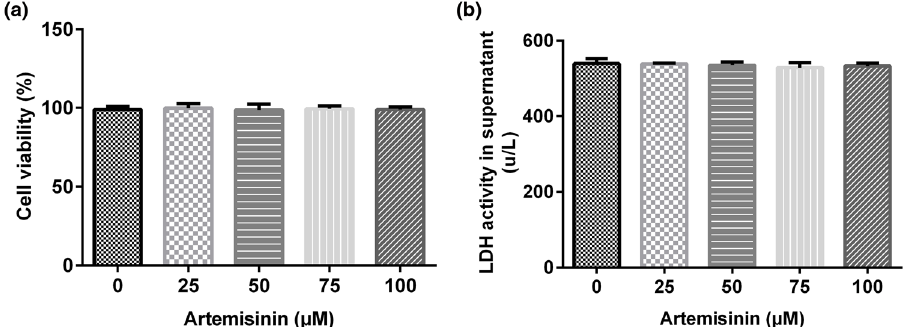
Figure 1: Cytotoxic e ff ect of ART on SH - SY5Y cells. SH - SY5Y cells were treated with ART at di ff erent concentrations ( 0, 25, 50,75, and 100 μ M ) for 24 h. Di ff erent ART concentrations had no signi fi cant e ff ect on SH - SY5Y: ( a ) cell viability and ( b ) lactate dehydrogenase